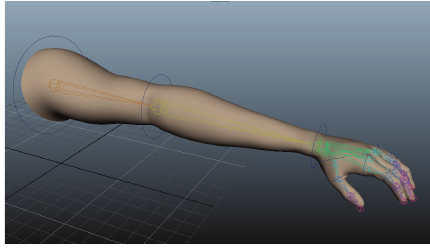
Figure 4: Model with ring